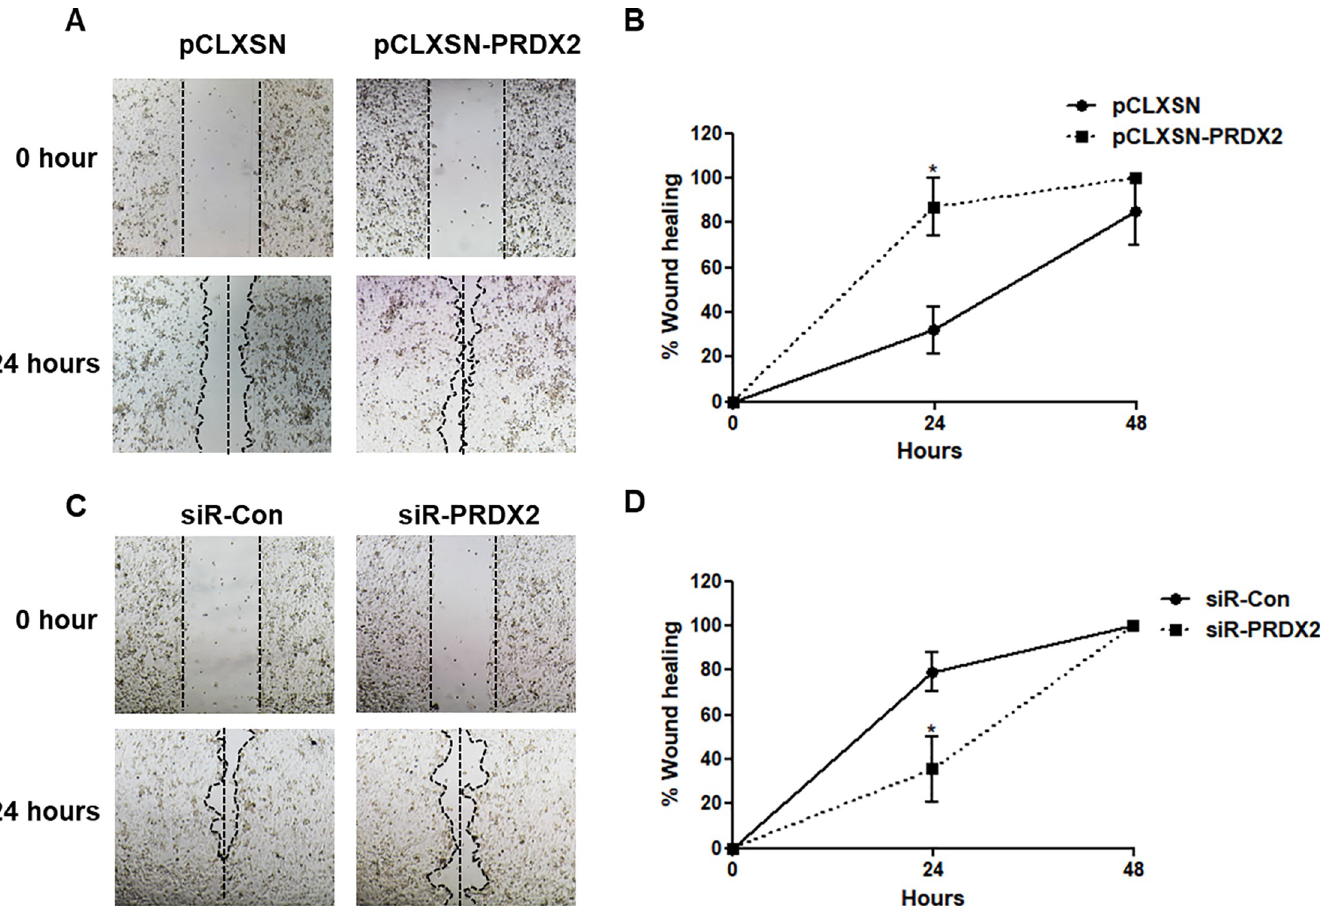
Fig 5. Cell migration in PRDX2-overexpressing cells and knockdown ORL-48T cells using a wound-healing assay. ORL-48T transduced with retrovirus-carrying pCLXSN or pCLXSN-PRDX2 (A and B) and transfected with siRNA-Control (siR-Con) and siR-PRDX2 (C and D) were maintained in DMEM/F12 medium with 1% FBS. After incubation for 24 hours, a wound was created and measured at 0, 24 and 48 hours using NIS-Elements Advanced Research Imaging Software version 3.0 and the 4x objective lens of an inverted microscope. Statistical comparisons were done using paired t-tests of triplicate experiments. � denotes statistically significant differences as P <